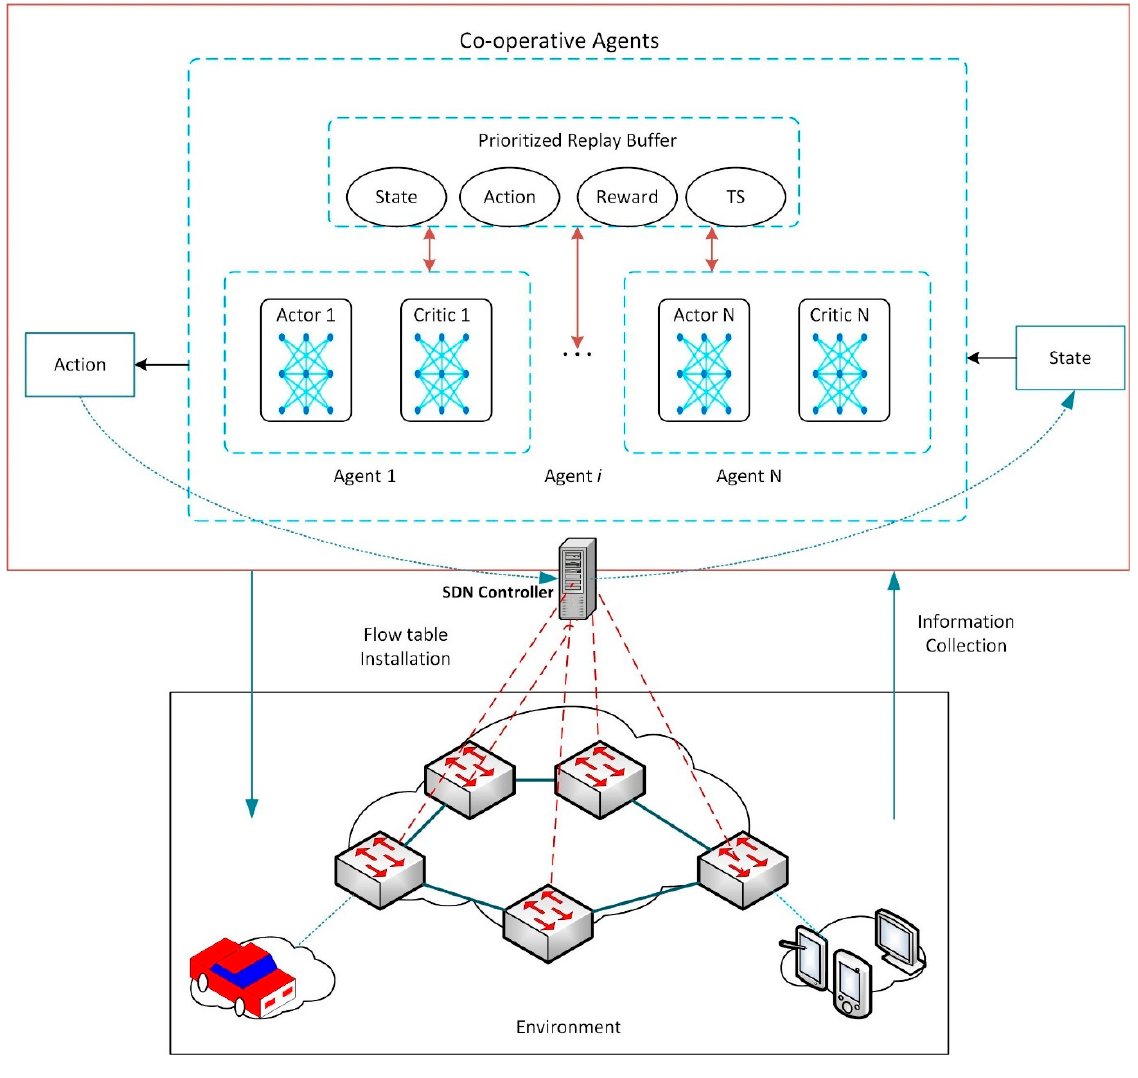
Figure 4. MARL. Figure 4.